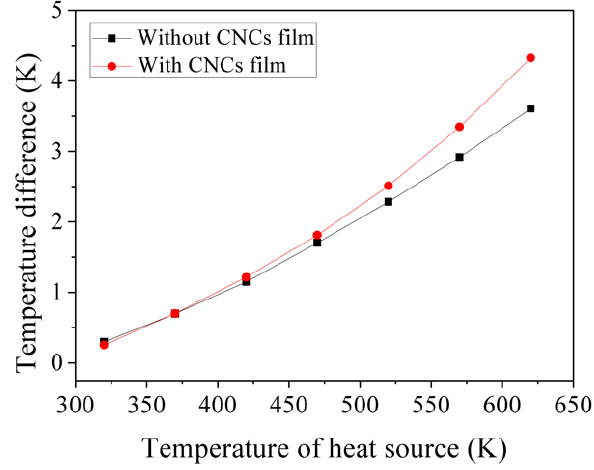
Figure 13. Temperature difference of the microgenerator.